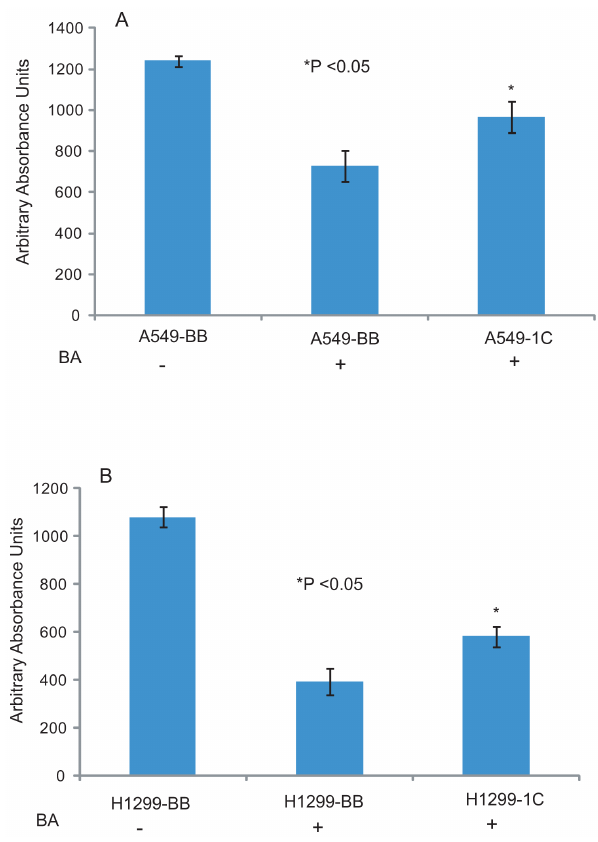
Figure 5. Betulinic acid effects on Piwil1 gene expression. Piwil1 mRNA expression was assessed in the presence and absence of serum and BA in the lung cancer cell lines A549 (A) and NCI-H1299 (B). RT-PCR data show that piwil1 expression was down-regulated by BA in the absence and presence of serum. PCR reactions were set in triplicates and Cyclophillin was used as an internal loading control and used to normalize the relative expression levels using the 2 2 DD method (26). RT- PCR reaction were run at three independent times.